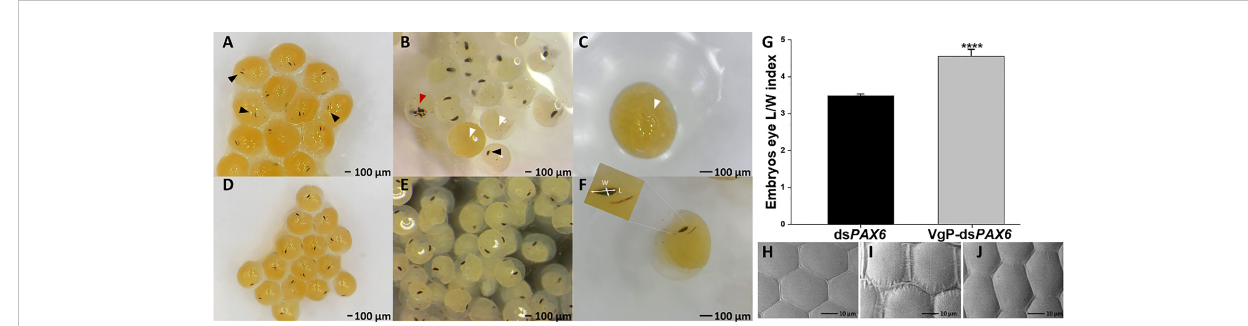
FIGURE 6 Vg-dsRNA complex injected into reproductive females leads to retarded eye development in the embryos and affects the shape of the ommatidium in advanced larva stages. Embryos detached from a mother injected with (KH) 9 VgP-ds PAX6 (A – C) or ds PAX6 (D – F) . Embryos possessing remnant or no eye development (white arrowheads), partially developed eyes (black arrowheads), and embryo with a cyclops eye (red arrowhead). (G) Average length/width index of eye pigmented area of embryos (n=10 from each female) from ds PAX6- (black column, n=3) or (KH) 9 VgP-ds PAX6- (gray column, n=4) treated females. Asterisks indicate a signi fi cant difference between (KH)9VgP-dsPAX6 and dsPAX6 groups (P< 0.0001) four asterisks indicate high signi fi cant difference (P< 0.0001). (H – J) SEM images of the normally developed eye (H , control ) and irregularly developed eye in larvae of treated females (I , J)